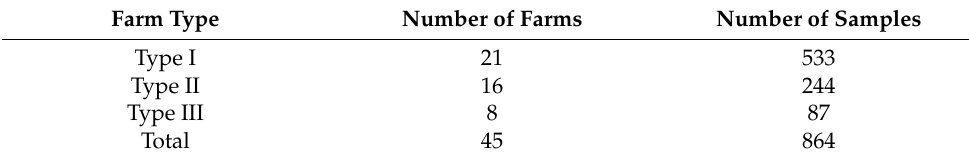
Table 1. Number of farms and animals sampled in each type of sheep farm